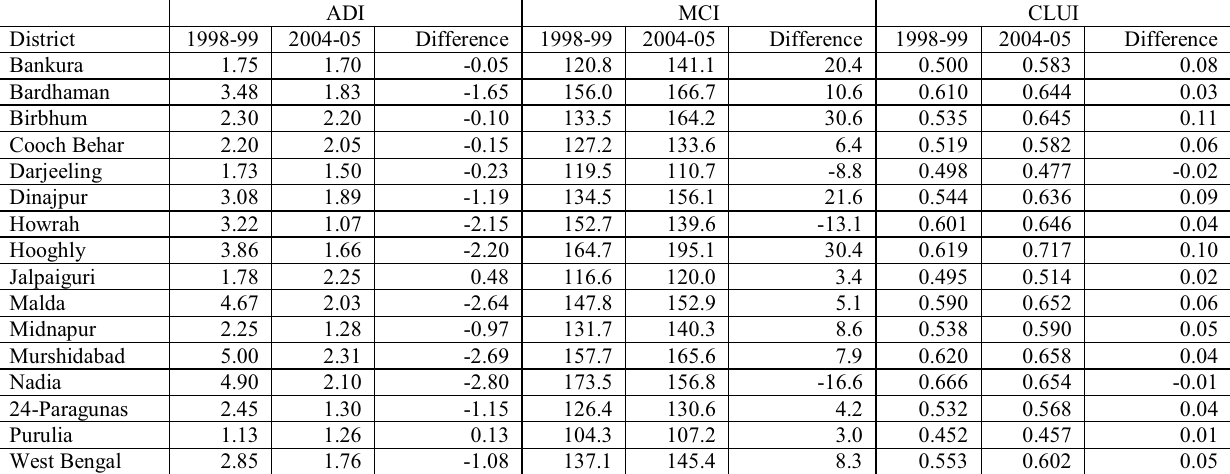
Table 6: Cropping system performance indices (1998-99 and